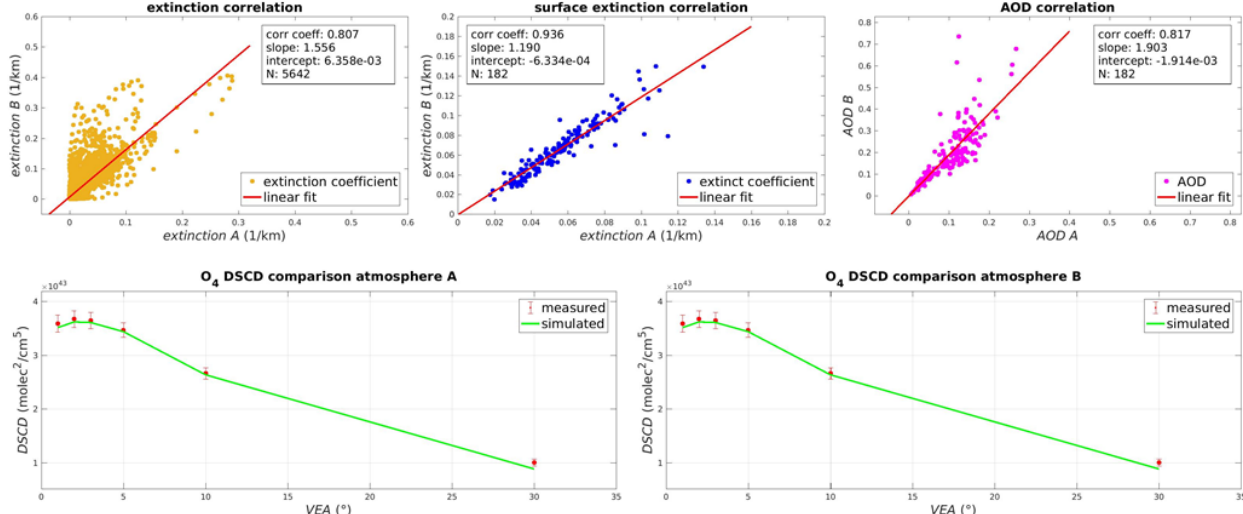
Figure 4. Comparison of retrieved aerosols using two different atmospheric profiles: the US standard (atmosphere A) and the US standard adapted to the altitude above sea level of Madrid (atmosphere B). The comparison was carried out for a clear sky day (11 May